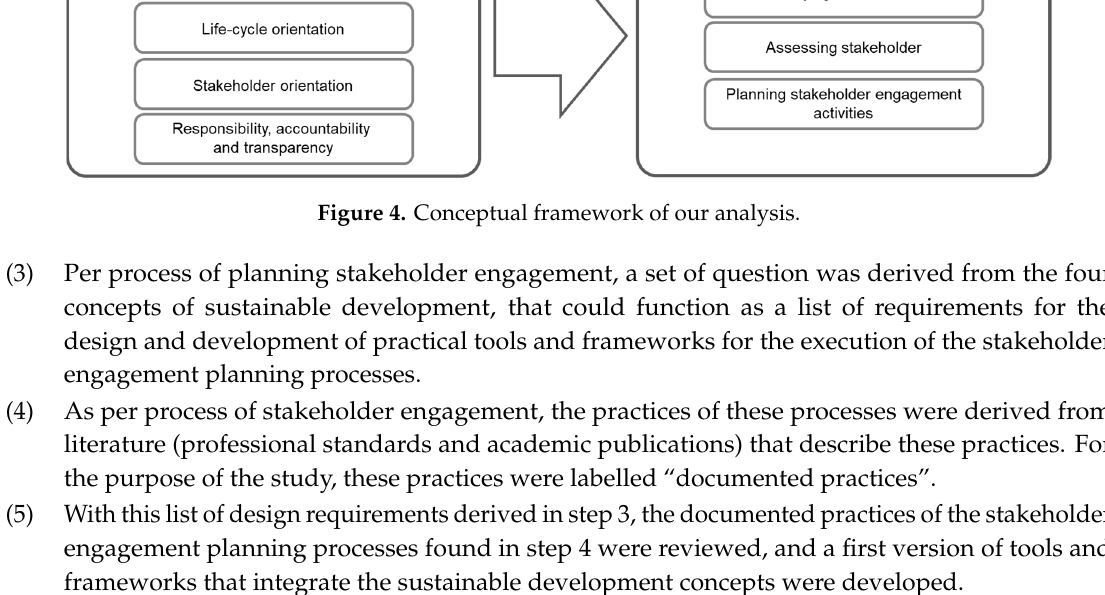
Table 4. Questions about the planning project stakeholder engagement processes derived from the concepts of sustainable development.